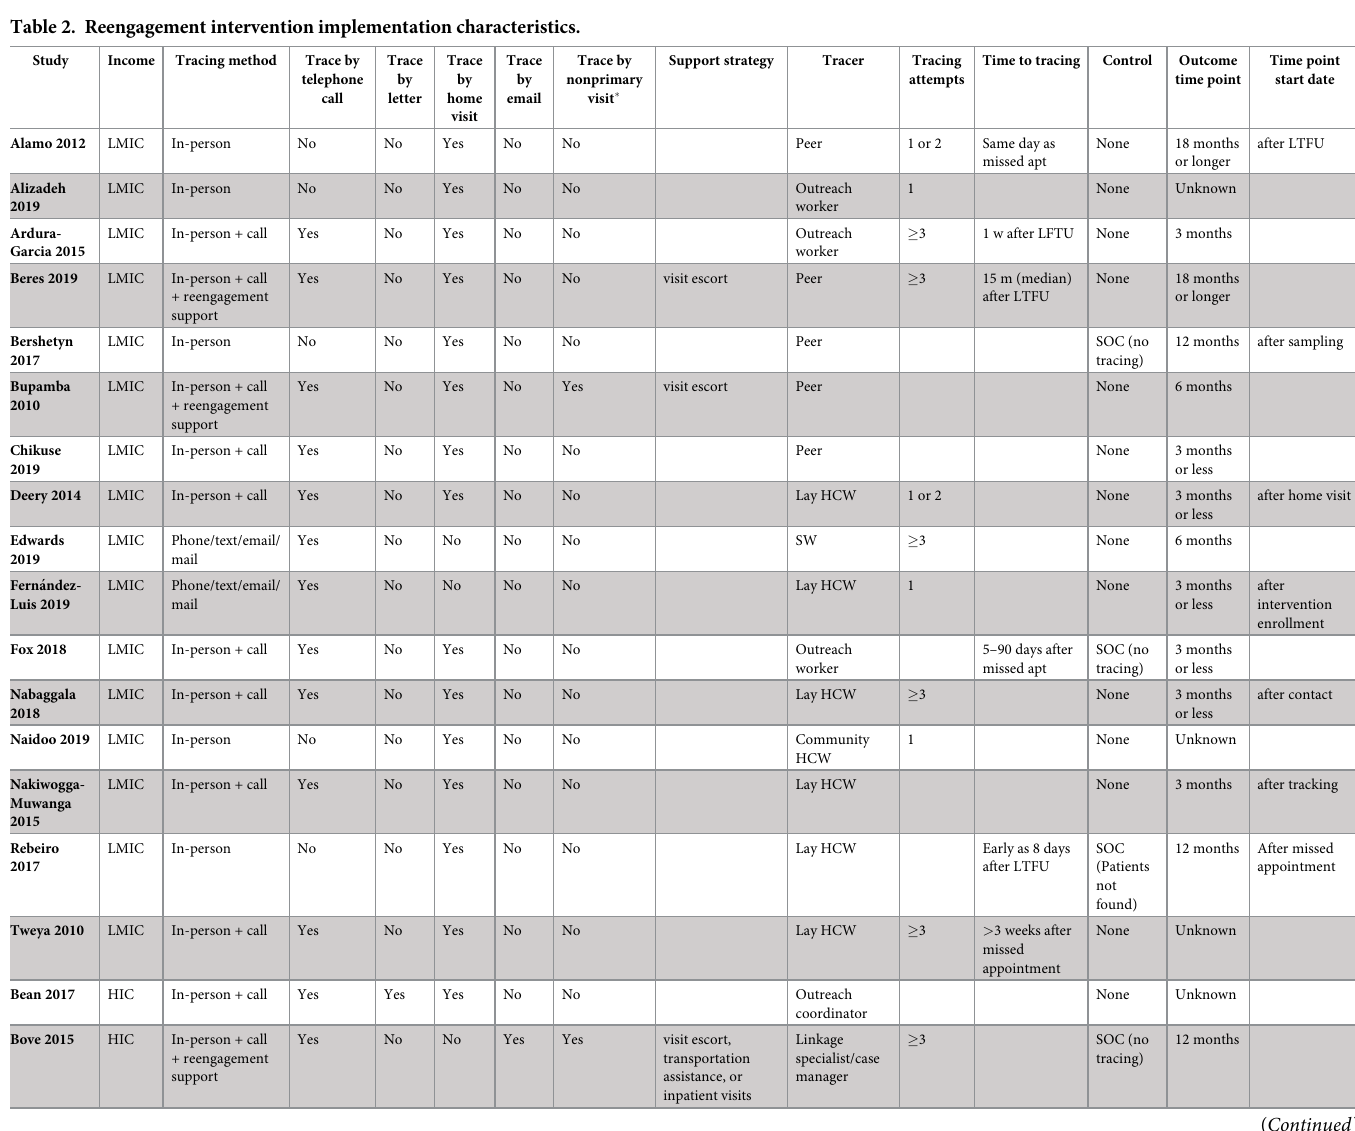
Table 2. Reengagement intervention implementation